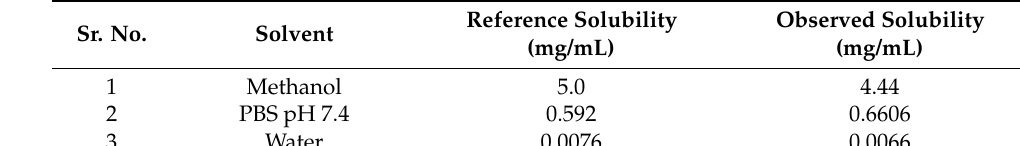
Table 4. Solubility of the drug in different solvents.